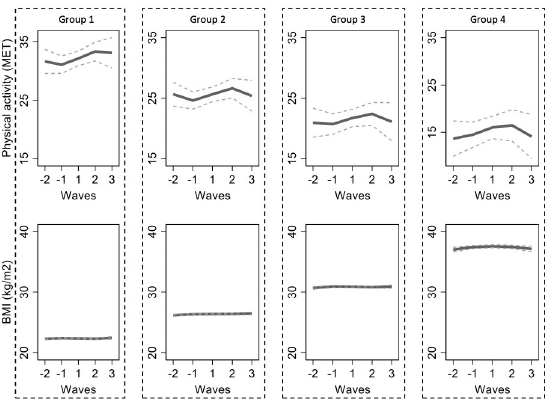
Fig 2. Trajectories of BMI and physical activity in five study waves during retirement transition. Each study wave is one year apart from each other.